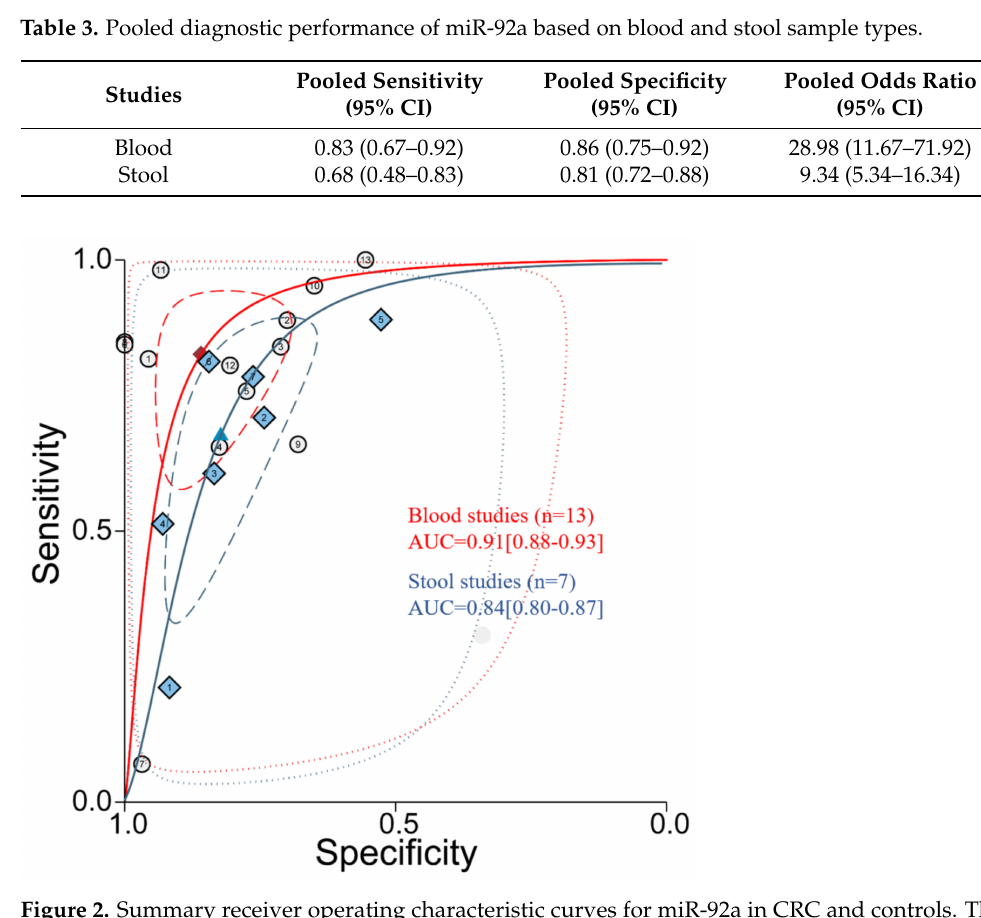
Figure 2. Summary receiver operating characteristic curves for miR-92a in CRC and controls. The pooled blood studies ( n = 13) for CRC had an AUC of 0.91 (95% CI: 0.88–0.93). The pooled stool studies ( n = 7) for CRC had an AUC of 0.83 (95% CI: 0.80–0.86). n means the included studies. Circles represent included blood studies, and squares represent included stool